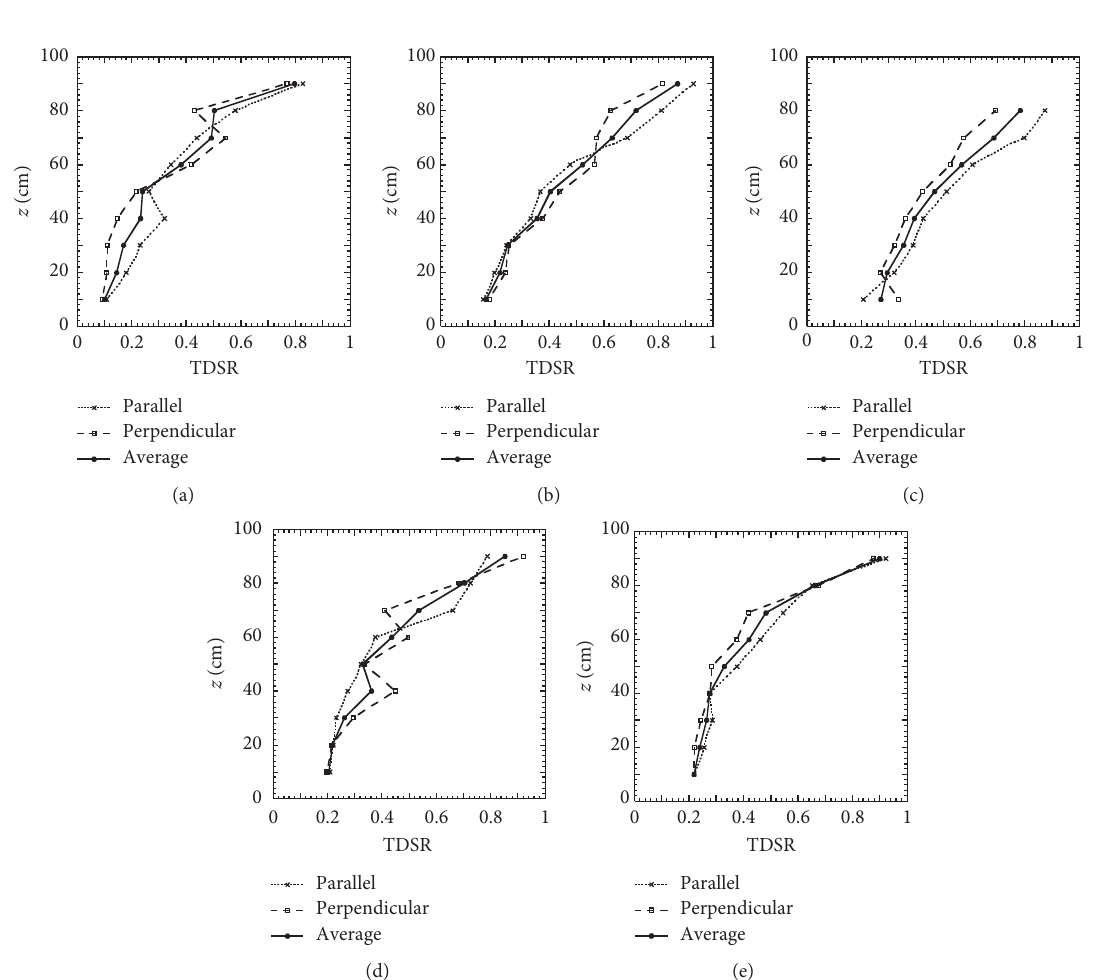
Figure 3: Vertical profiles of transmissivity of downward solar radiation (TDSR) within the rice canopy in every 10cm in the paddy field on August 7, 2014 (a–e). (a) 8:50, (b) 10:50, (c) 12:40, (d) 14:50, and (e)